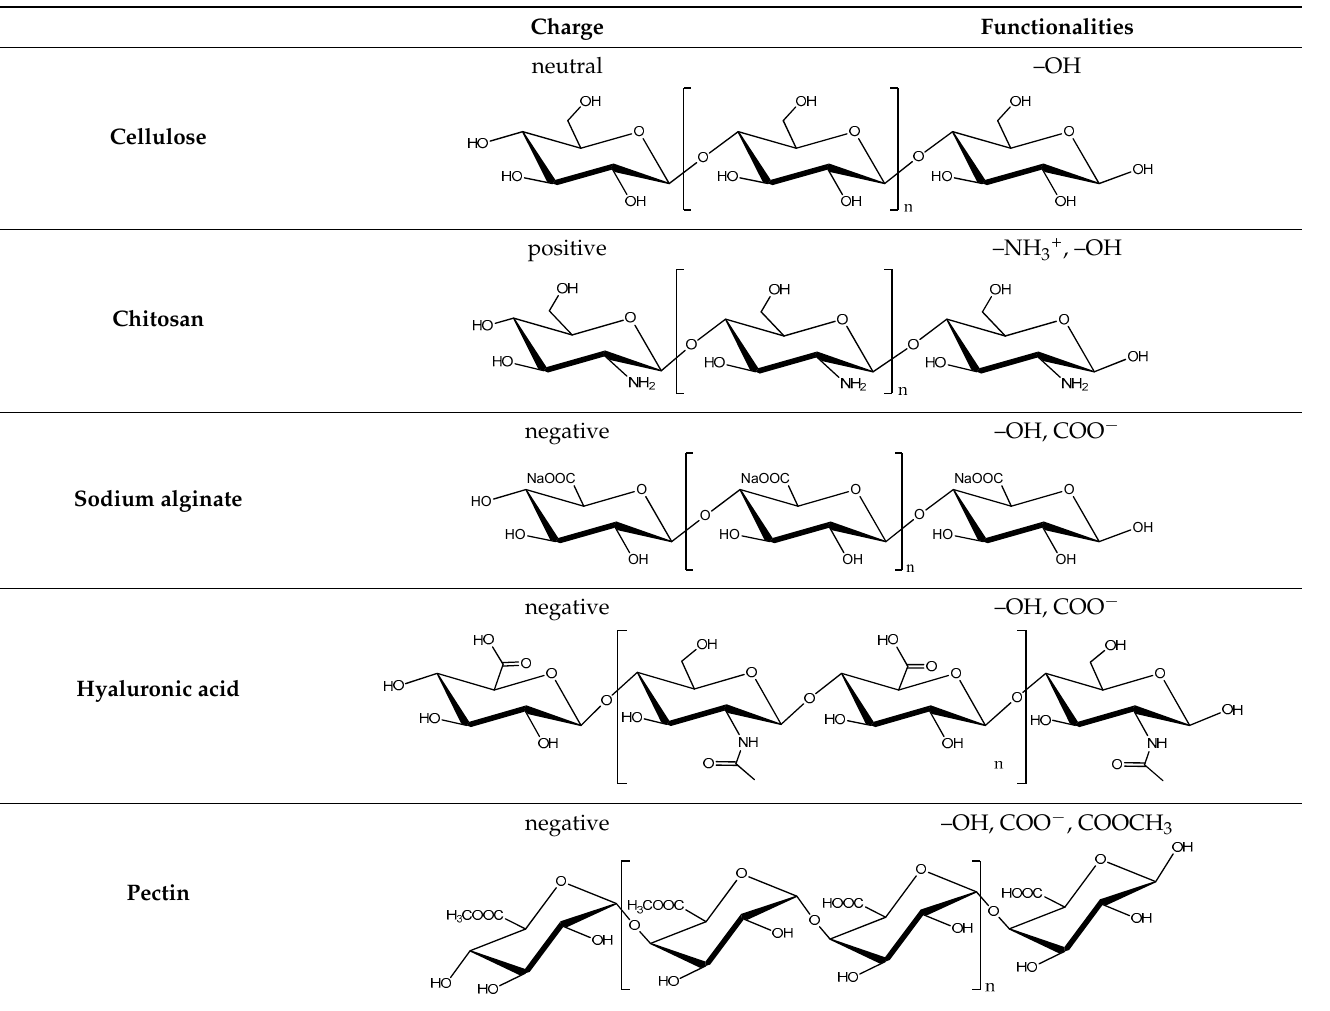
Table 1. Common polysaccharides used in 3D printing.